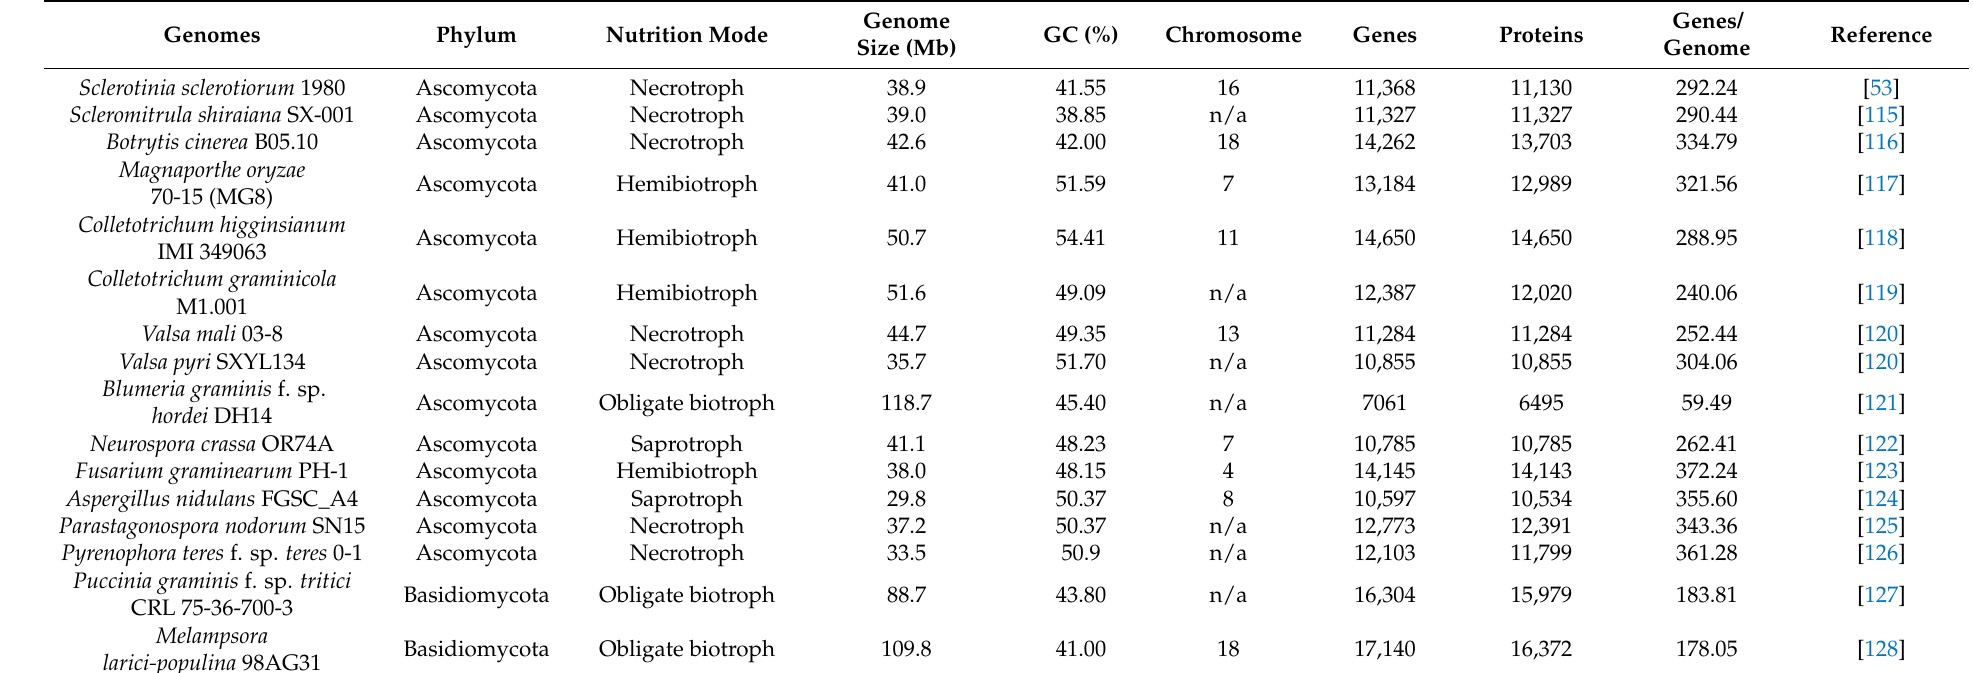
Table 2. Comparative highlight of genomes of various fungal